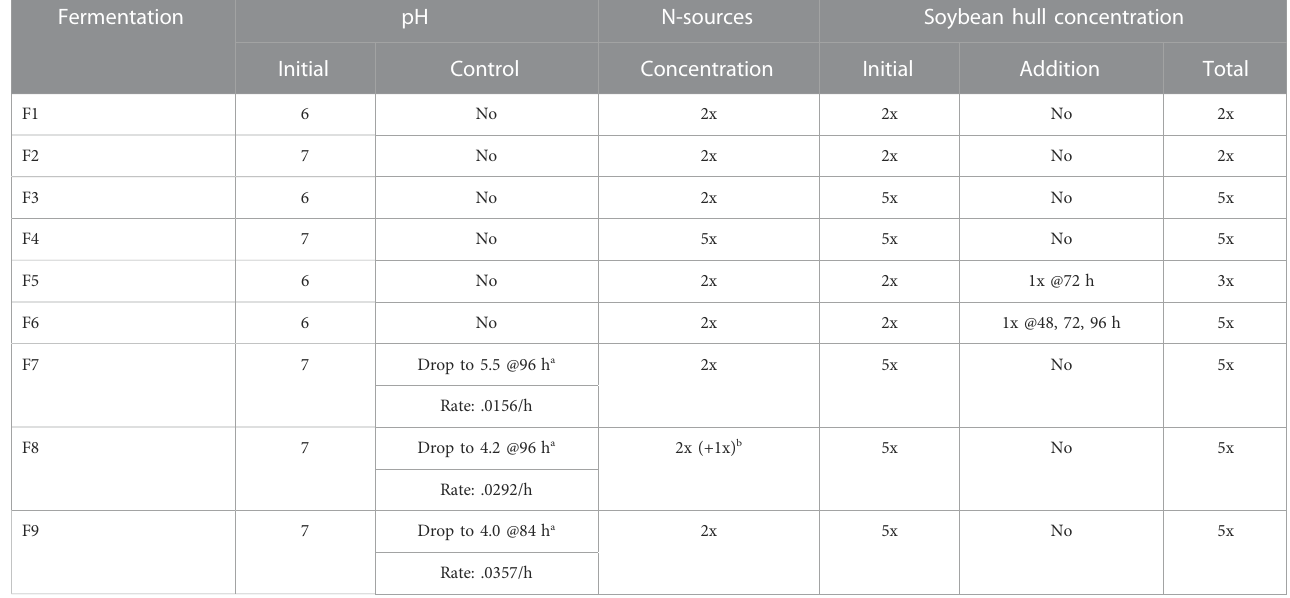
TABLE 1 Fermentations made with different pH and soybean hull and non-hull N-sources concentrations and addition schemes. Fermentation pH N-sources Soybean hull concentration